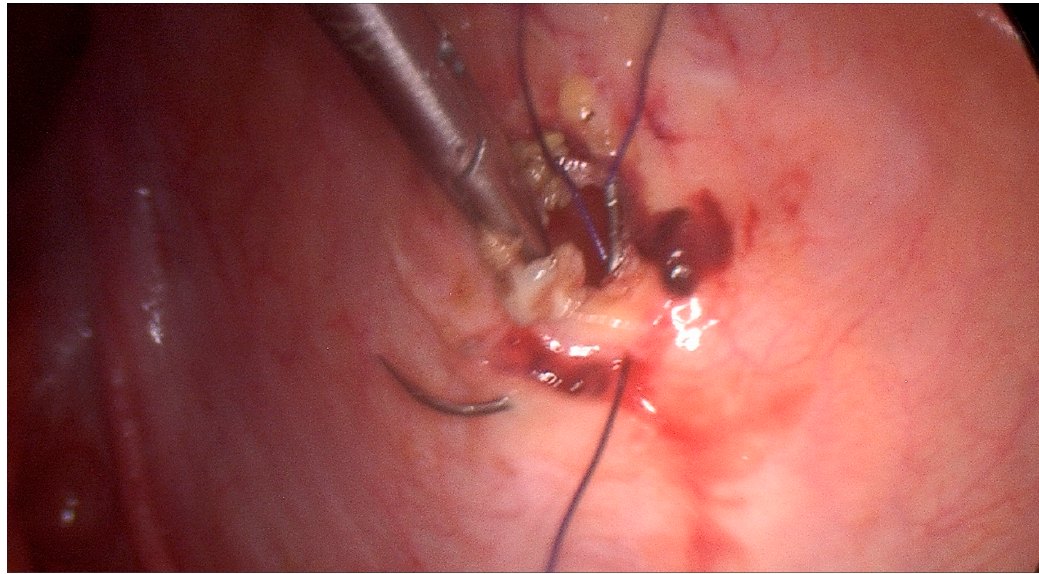
Figure 2. Intraoperative view and suturing of the bladder perforation.